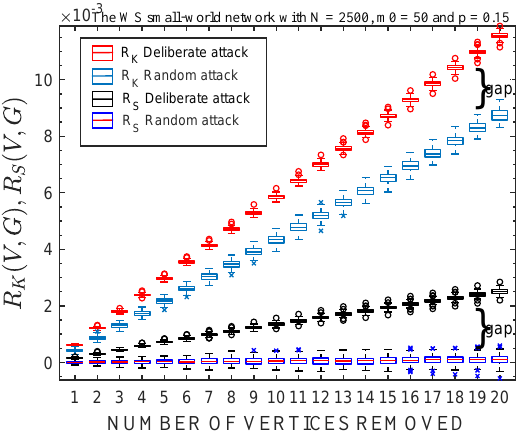
Figure 6. The figure shows the calculation and analysis of deliberate attacks and random attacks of R S ( V , G ) and R K ( V , G ) on the WS small − world network. They are all calculated by generating a 2500-order WS small − world network with m 0 = 50 and p = 0.15 for 10 2 times, and the results are displayed in the form of box